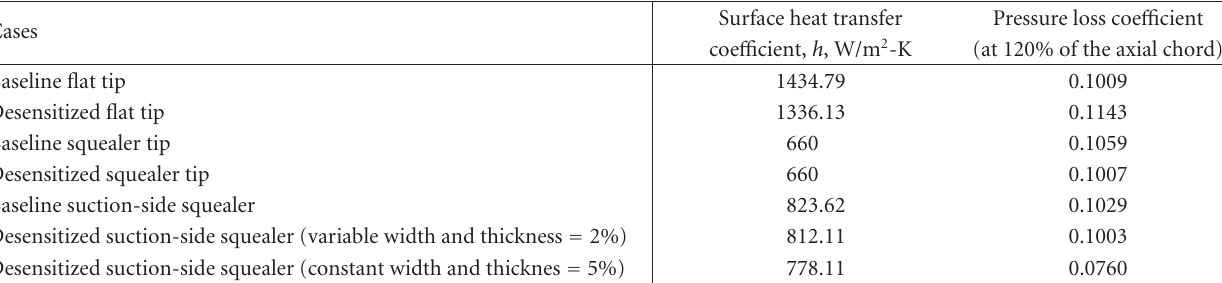
Table 1: Comparison of heat transfer coe ffi cient and pressure loss coe ffi cient for various cases.